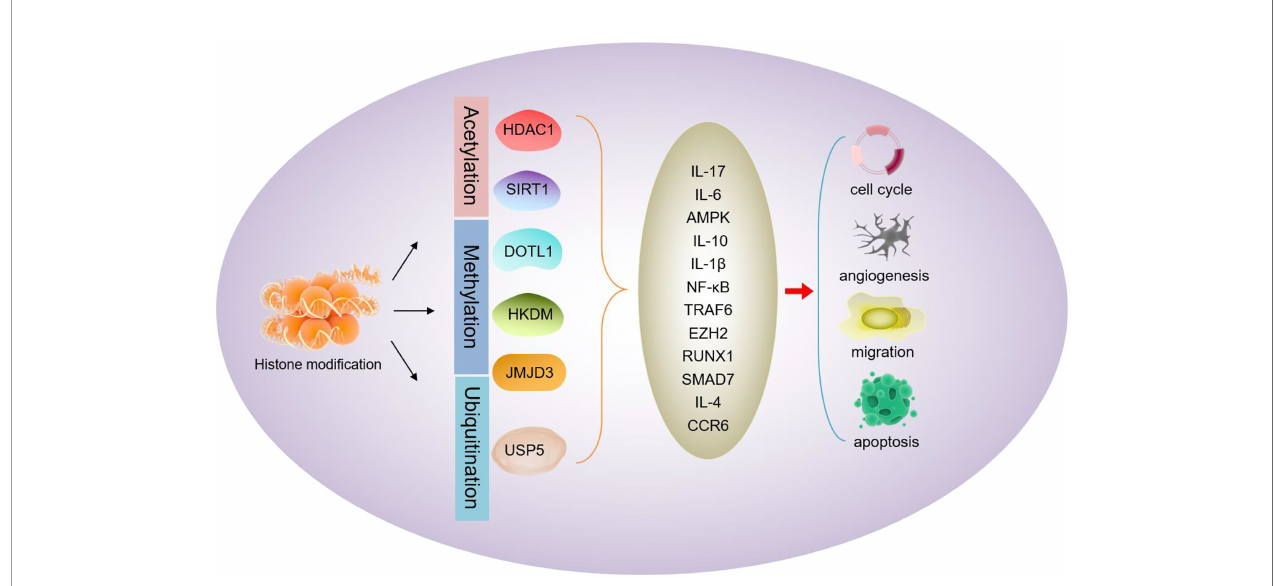
FIGURE 2 | Schematic diagram of histone modi fi cations mediating RA progression. Acetylation (HDAC1, SIRT1), methylation (DOTL1, HKDM, JMJD3), or ubiquitination (USP5) of RA-related proteins mediates the expression of RA factors (IL-17, IL-6, AMPK, IL-10, IL-1 b , NF- k B, TRAF6, EZH2, RUNX1, SMAD7 IL-4, CCR6, etc.), thereby affecting the proliferation, invasion, and apoptosis of RA-related